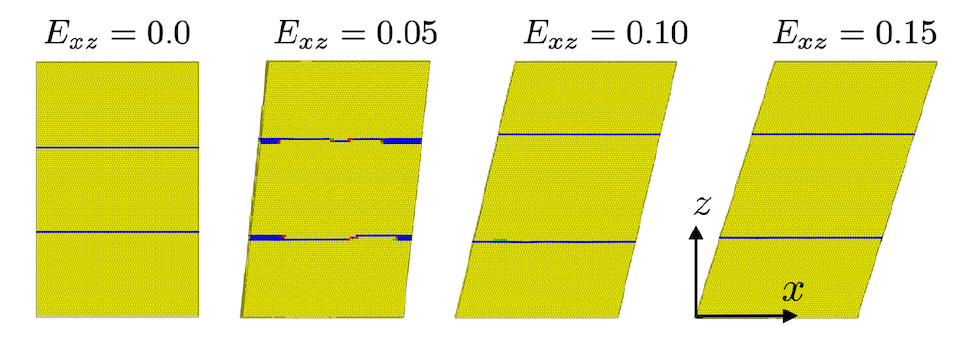
Figure 4. Twin boundary motion and oscillation during T xz loading corresponding to the stress-strain behavior displayed in Figure 3 (middle right).